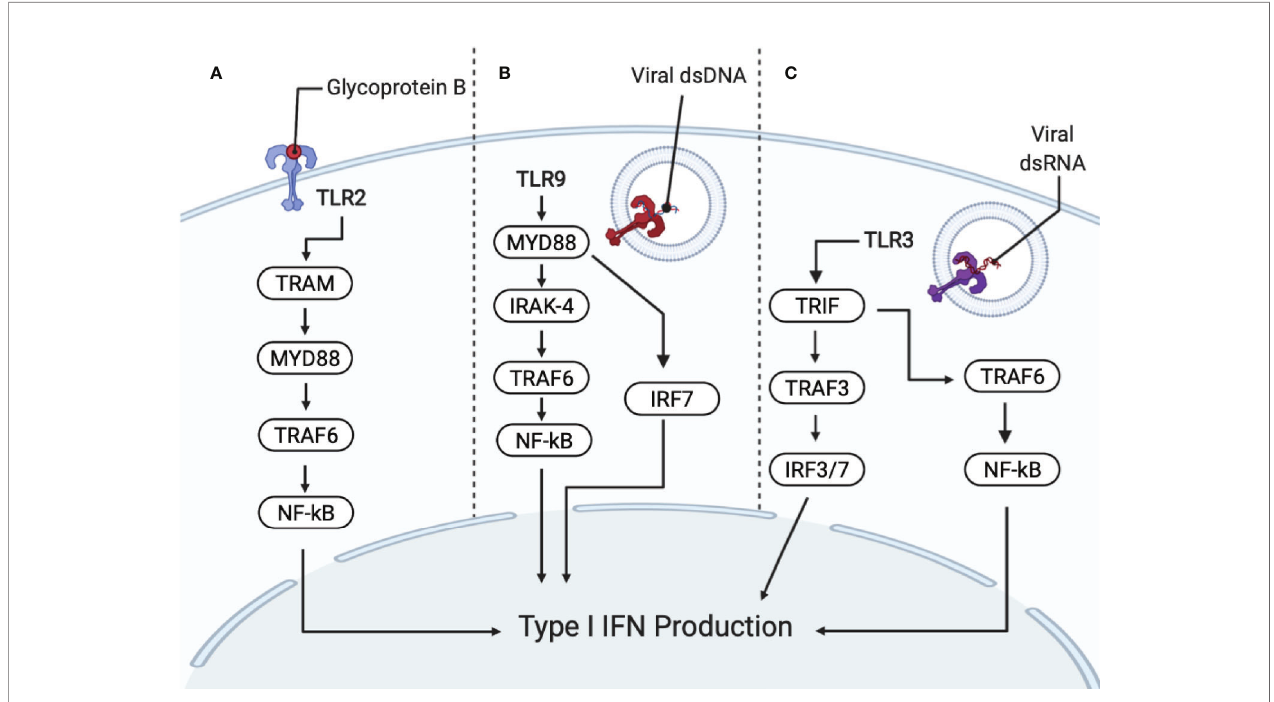
FIGURE 3 | Recognition of HSV – 1 by PRRs (pattern recognition receptors) activates interferon (IFN) and cytokine production. PRRs include toll – like receptors TLR2, TLR9 and TLR3. (A) TLR2 recognizes HSV – 1 glycoprotein B (gB), promoting NF – k B activation and the secretion of interleukin (IL) – 8 through the MyD88/TRAF6 – dependent signaling pathway. Subsequent degradation of I – k B a (an inhibitor of NF – k B) allows NF – k B to translocate to the nucleus. TLR2 also signals through TRIF – related adaptor molecule (TRAM) and MyD88 for IFN production. (B) TLR9 senses viral DNA, which contains unmethylated CpG motifs. TLR9 is dependent on IRAK – 4 and MyD88 – dependent pathways. MyD88 and TRAF6 resulting in the activation of the NF – k B pathway for downstream cytokine secretion. TLR9 activation also signals IRF7, which produces type I IFNs. (C) TLR3 recognizes dsRNA, which are produced during viral replication. TLR3 activates MyD88 – independent signaling cascade through the Toll/IL1 receptor domain, containing adaptor inducing IFN b (TRIF) and TRAF3, resulting in IRF3/7 translocating to the nucleus, for the production of type I IFNs. TLR3 also signals TRIF and TRAF6, resulting in NF – k B